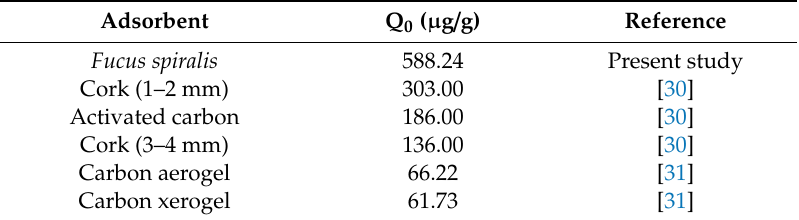
Table 2. Maximum biosorption capacity based on the Langmuir isotherm by different adsorbents for cypermethrin.